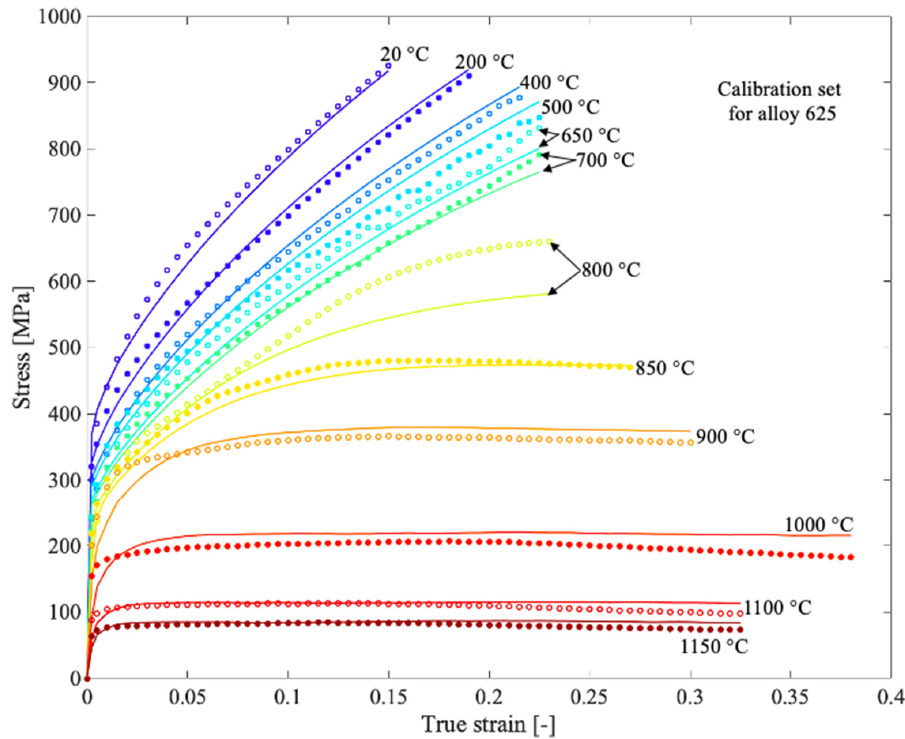
Figure 2 . Measured flow stress curves (discrete points) for alloy 625 and corresponding computed result (solid lines) from the material model after calibration. The tests were performed with a nominal strain rate of 0.01 s − 1 .